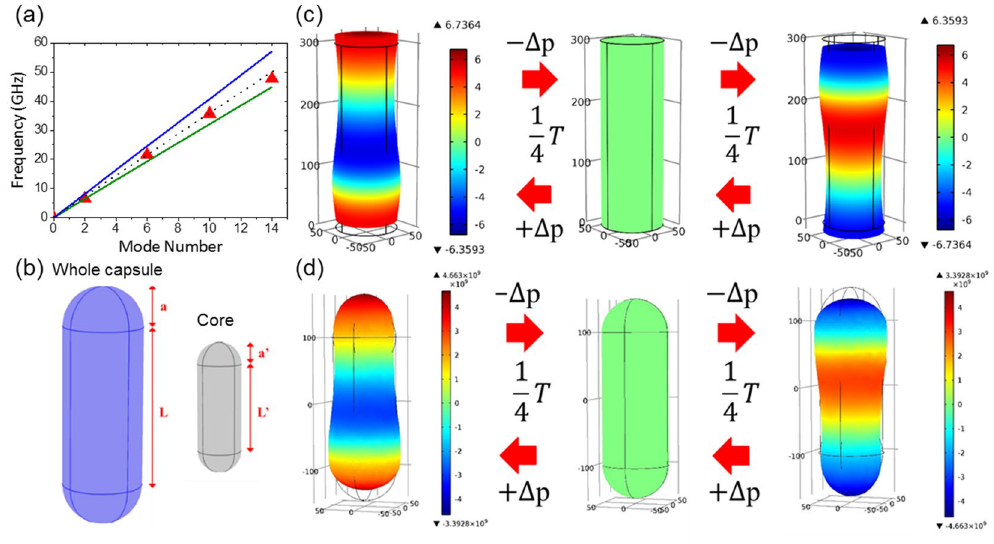
Figure 5. Longitudinal modes and vibrational frequencies. ( a ) A figure showing the measured resonant microwave absorption frequency (red solid triangles) as a function of the longitudinal mode order. Relationships based on Eq. 6 are shown in blue and green lines, assuming longitudinal sound velocities of 1920m/s and 2450 m/s respectively. The dot dash line shows the relationship with a longitudinal sound velocity of 2100 m/s. ( b ) Schematic showing a nano-capsule and its inner core. a is the radius of the capsule and hemispheroid, L-2a is the length of the center cylinder; and L is the total length of the capsule. Similarly, a’ is the radius of core, and L’ is the length of core. ( c ) The FEM simulation result of the n = 2 longitudinal mode vibration of a nano-cylinder with a 0.5 dimension-ratio between the core and shell. Color bar represents the displacement field. T: Period; ∆ p : difference of dipole moment between the balance state and the maximum compression/extension state. ( d ) The FEM simulation result of the n = 2 longitudinal mode vibration of a nano- capsule with a 0.5 dimension-ratio between the core and